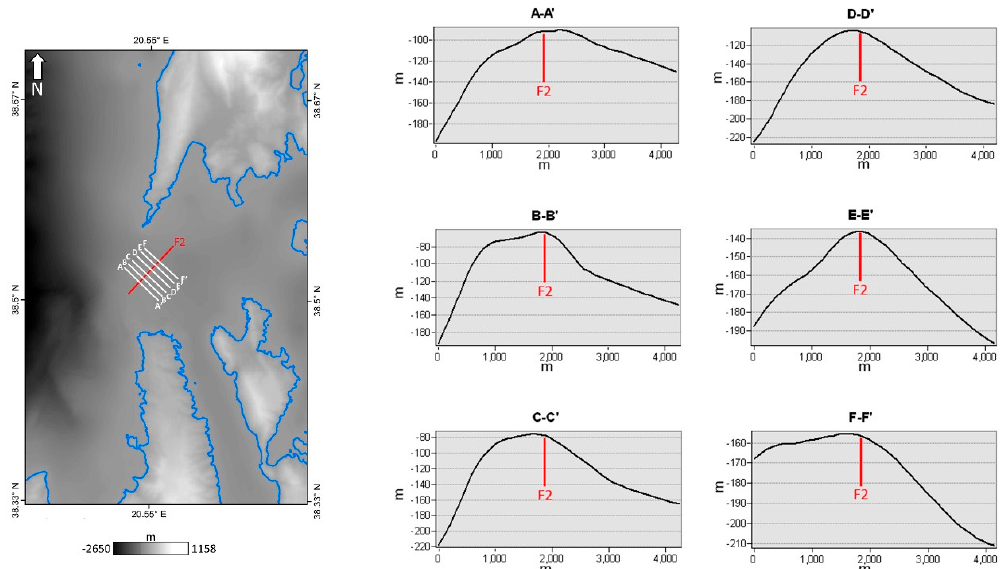
Figure 4. Topography [38] of the study area. A profile screening along the segment F2 indicates the existence of a seafloor feature. The red line is the southern fault segment F2. The white lines A-A’, B-B’, C-C’, D-D’, E-E’, and F-F’ are the bathymetric profiles. In each profile graph, the location of F2 along the profile is noted with a red line.